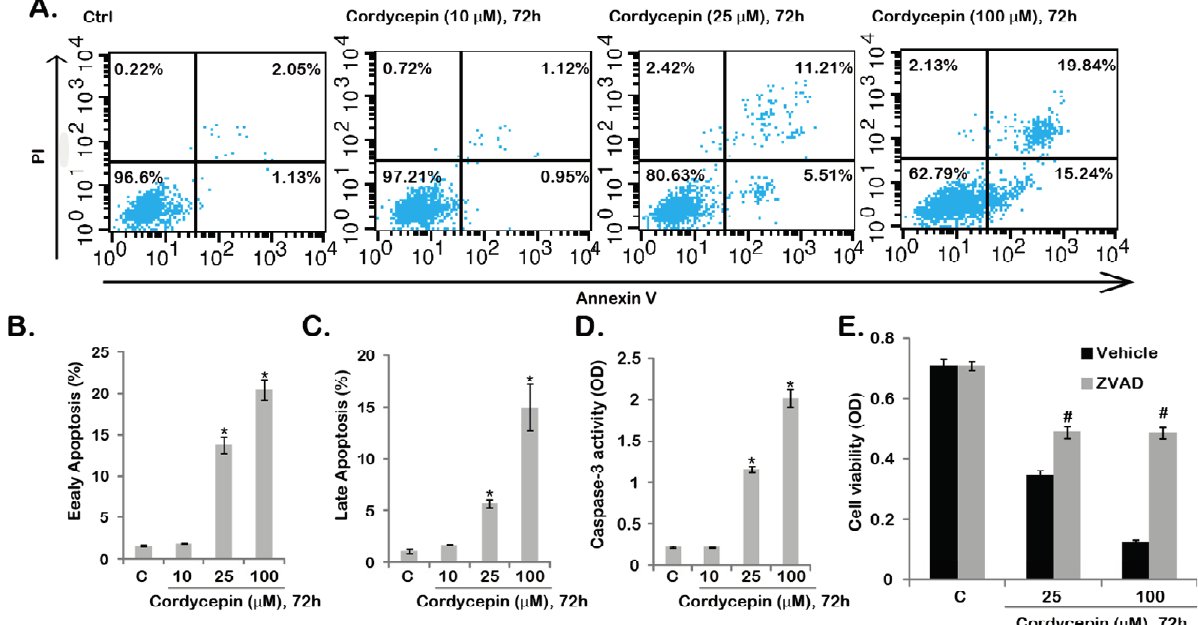
Figure 2. Cordycepin induces GBC-SD cell apoptosis. GBC-SD cells were treated with indicated cordycepin (10–100 μ M) for 72 h, cell apoptosis was tested by Annexin V/PI FACS ( A – C ) and Caspase-3 activity assay ( D ); Note that for Annexin V FACS assay, the results of five sets of experiments were quantified ( B , C ); GBC-SD cells were treated with z-VAD-fmk (50 μ M) for 1 h, followed by cordycepin (25/100 μ M) stimulation, cells were further cultured for 72 h, and cell viability was tested ( E ); Experiments were repeated five times. * Stands for p < 0.05 vs. control (“C”) group ( B – D ); # Stands for p < 0.05 vs. vehicle group ( E ). Vehicle: 0.1% DMSO ( E